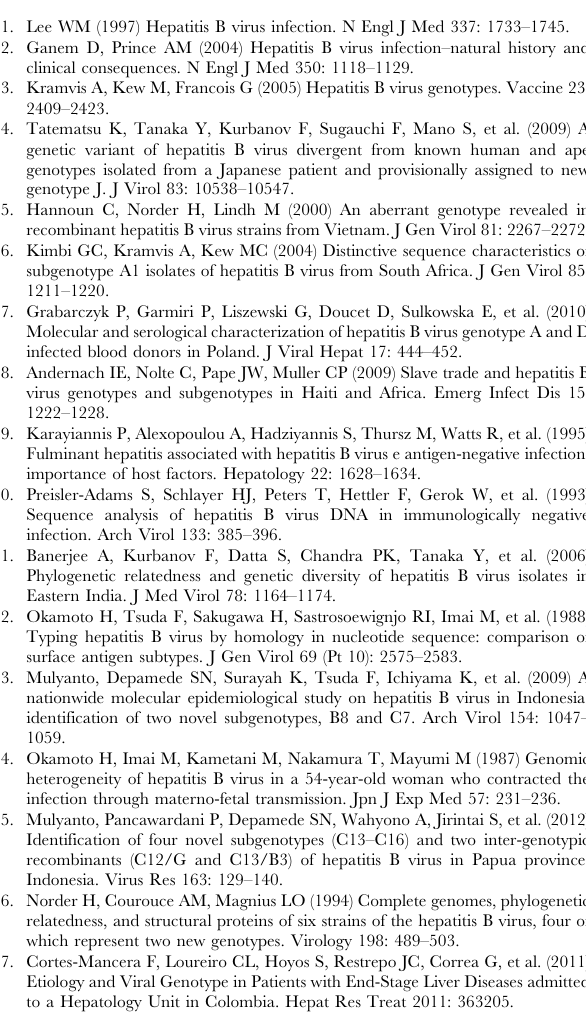
(TIFF) Figure S2 Number of HBV genomes with or without CpG island I within 139 partial genome sequences belonging to different genotypes. (TIF) Table S1 The genotypes/subgenotypes, countries of origin of isolates, and GenBank accession numbers of the HBV sequences analyzed in this study. (DOC) Table S2 The genotypes, countries of origin of isolates, and GenBank accession numbers of the HBV